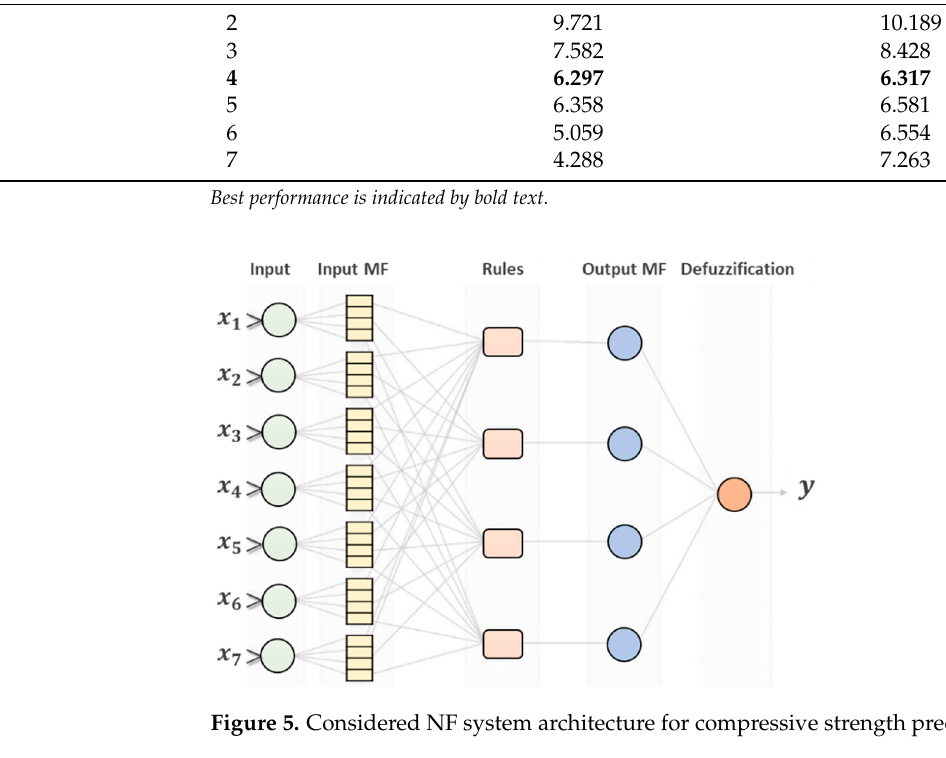
Table 4. Performance of predictive models.